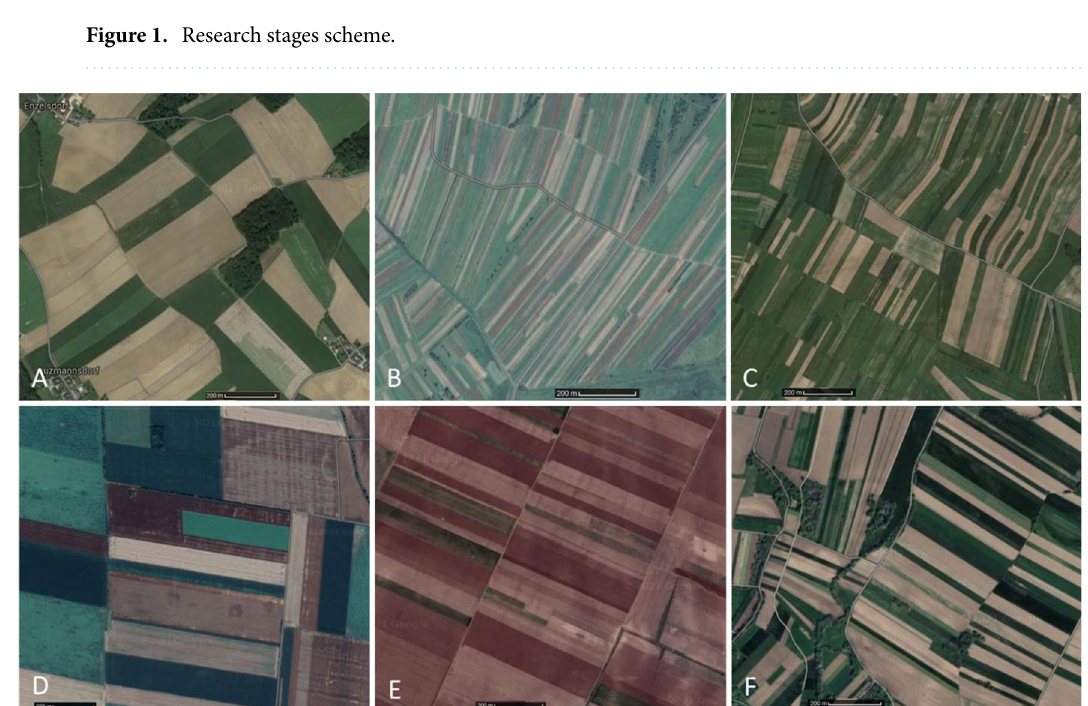
Figure 2. A local aspect of the spatial arrangement of fields (visual interpretation of w index) at the examples of East and Central Europe ( A -Austria/Lutzmandorf; B -Ukraine/Hruszów; C -Poland/Sułoszowa; D -Hungary/ Csanadapaca; E -Romania/Ramnicelu; F -Slovenia/Gradisce). Source: google